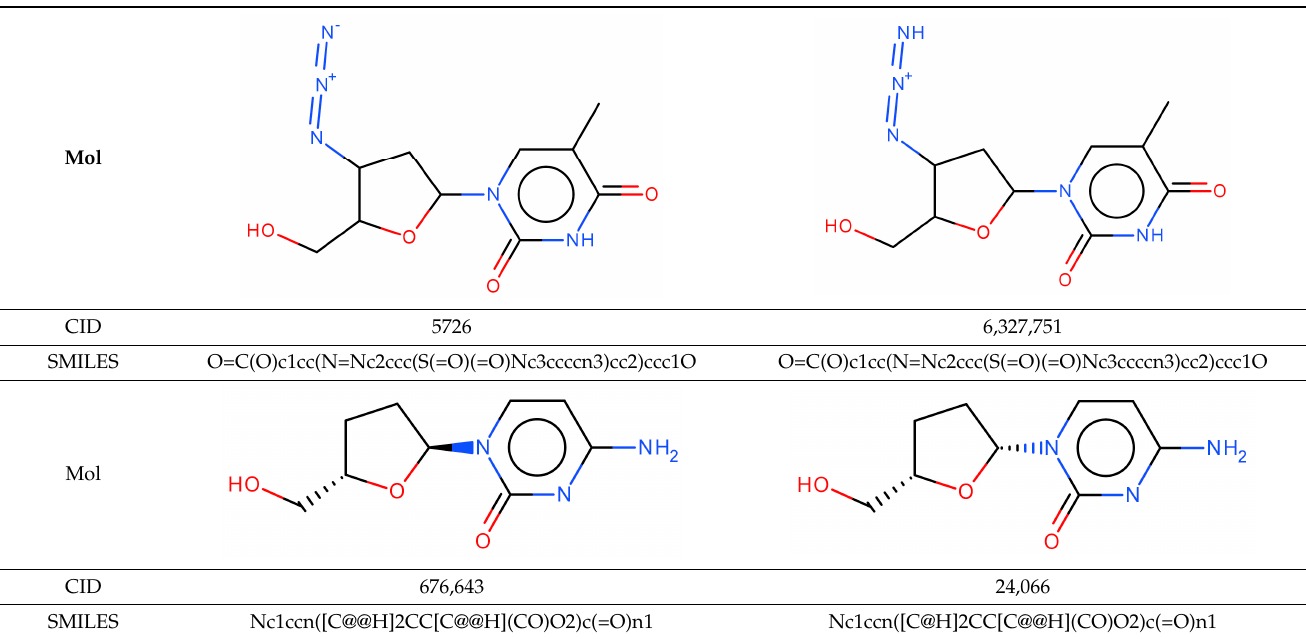
Table 2. Examples of how the duplicate analysis can be influenced by the chosen parameters. The duplicate analysis can be influenced by the chosen parameters. For example, molecules with PubChem CIDs 5726 and 6,327,751 are considered equal (and therefore duplicates) if the formal charge and the number of hydrogens are ignored. Instead, molecules with PubChem CID 676,643 and 24,066 are considered duplicates if the stereochemistry is ignored.